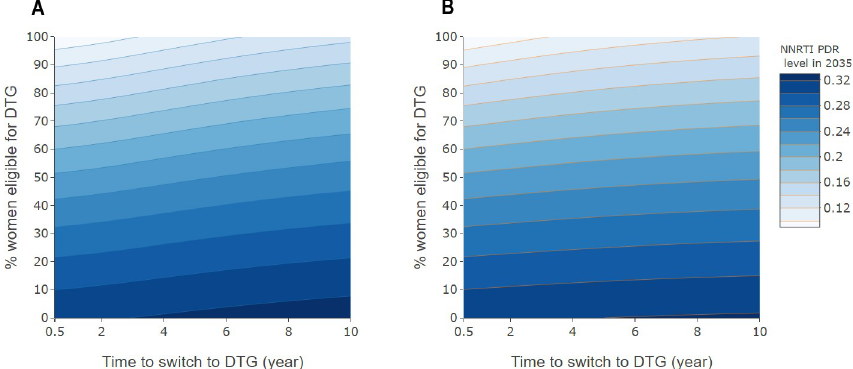
Fig 4. Level of NNRTI PDR in 2035, by rate of switching to DTG-based ART and percent women eligible for DTG-based ART. Panel A relates to patients on first-line ART with suppressed HIV-1 replication, and panel B to individuals failing NNRTI-based ART. The average time to switching (i.e., the inverse of the switching rate) varies from 0.5 to 10 years for individuals with viral suppression (panel A) or failure (panel B). ART, antiretroviral therapy; DTG, dolutegravir; NNRTI, non-nucleoside reverse transcriptase inhibitor; PDR, pretreatment drug resistance.